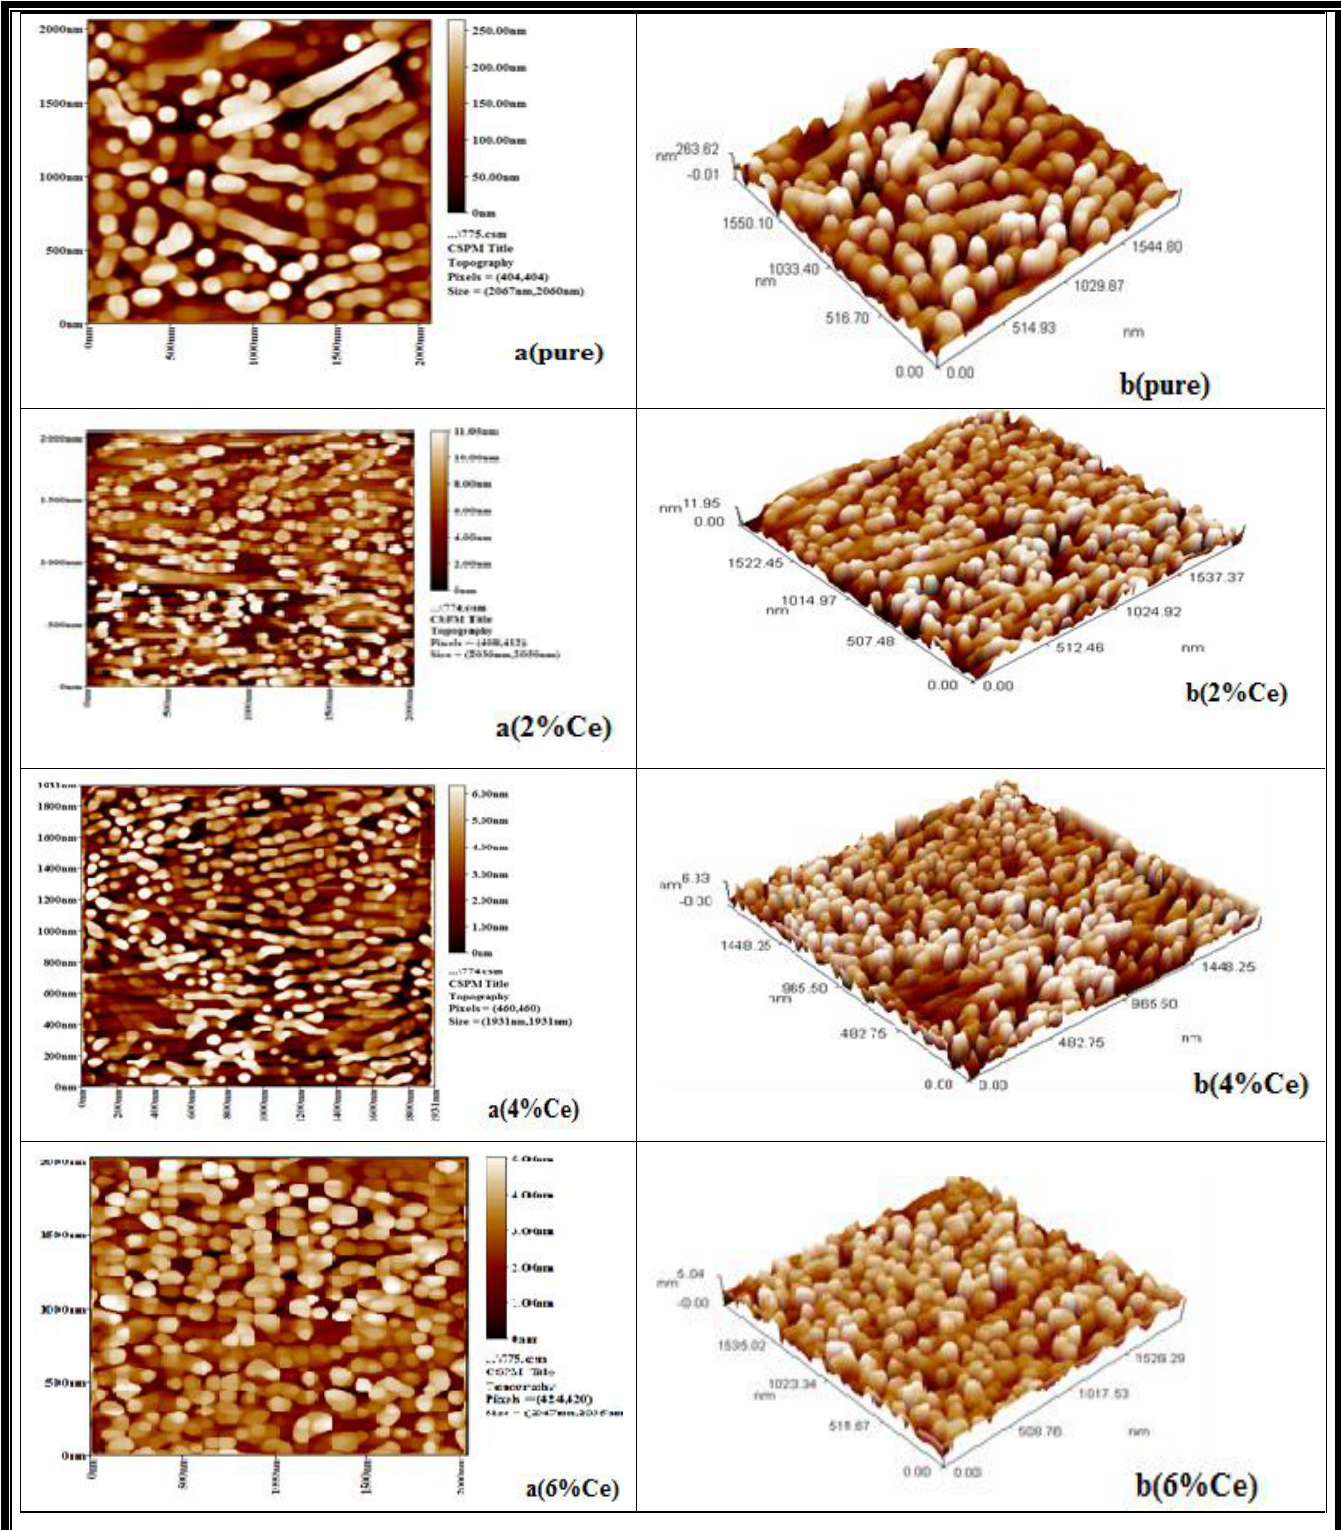
Fig. 3: AFM images (a) 2-D and (b) 3-D of prepared CdO films for on glass substrates at different concentration of